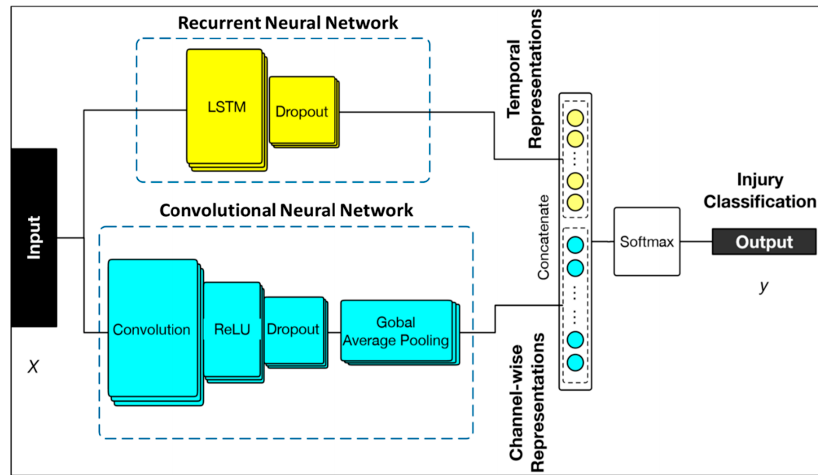
Figure 2. Machine learning architecture of the model used in the study. Hybrid neural network constructed of a recurrent neural network (Long Short-term Memory followed by dropout layer) and convolutional neural network (convolutional, Rectified linear unit (ReLU) activation unit and dropout and global pooling layers). Inputs were variables listed, with outputs being neurological injury